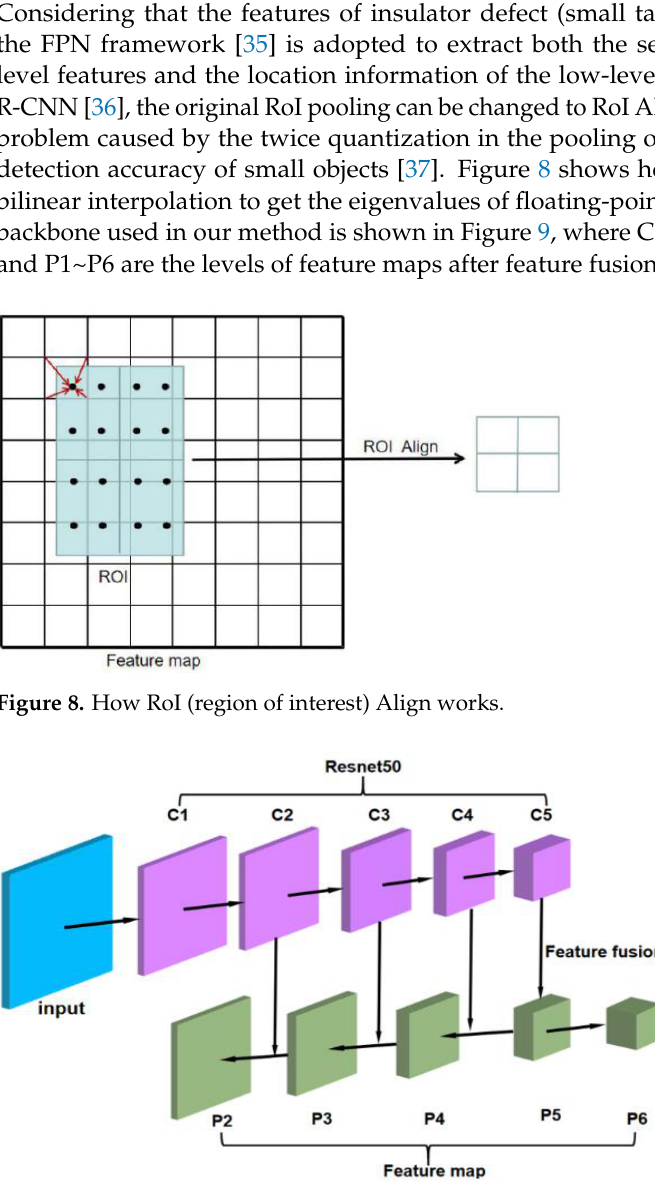
Figure 9. Framework of the improved backbone.